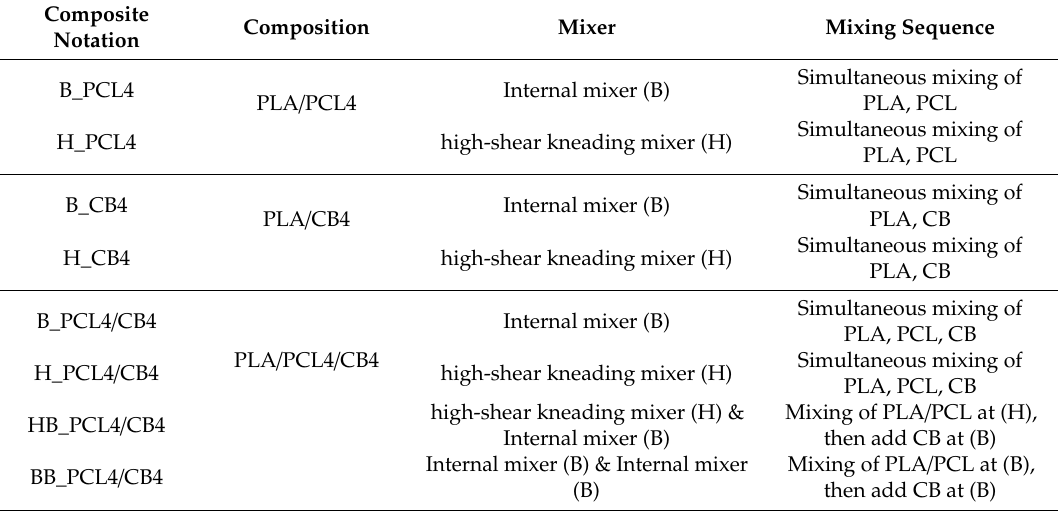
Table 2. Notation of PLA / CB4 and (PLA / PCL4) / CB4 composites depending on mixing